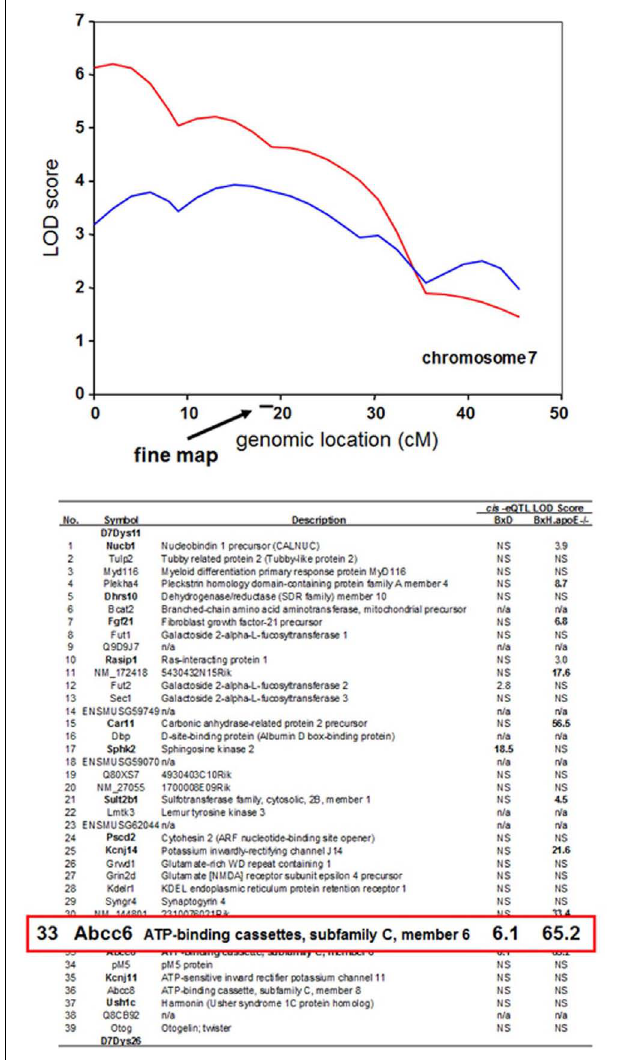
FIGURE 6 | Use of expression quantitative trait loci (eQTL) to prioritize candidate genes at a locus contributing to a complex trait .The trait of dystrophic cardiac calcinosis was mapped by linkage analysis in two mouse F2 intercrosses (BxD and BxH.apoe − / − ).The peak region in the two crosses contains a total of 39 genes. Expression array analysis on liver samples was carried out on mice, resulting in the mapping of several thousand cis -eQTL loci.The genes exhibiting cis -eQTL at the dystrophic cardiac calcinosis locus on chromosome 7 are shown according to their LOD scores.The Abcc6 transporter was the only gene exhibiting a significant cis -eQTL activity in both crosses. Genes exhibiting non-significant LOD scores are indicated by “NS,” and genes not on the arrays are indicated by “n/a.” [Figure based on data from Meng et al. (2007)].